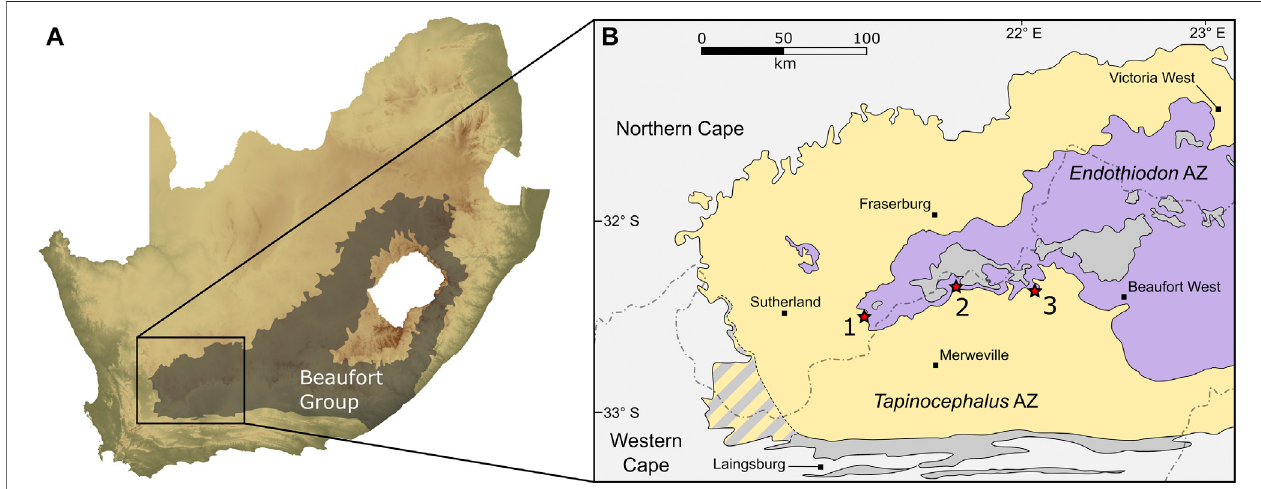
FIGURE2| MapshowingthestudyareawithintheBeaufortGroupinthesouthwesternpartoftheKarooBasinofSouthAfrica (A) ,andthethreelocalitiesalongthe contact of the Tapinocephalus and Endothiodon assemblage zones (B) . 1, Puntkraal; 2, Muggefontein; 3, Vanvuurenskop.